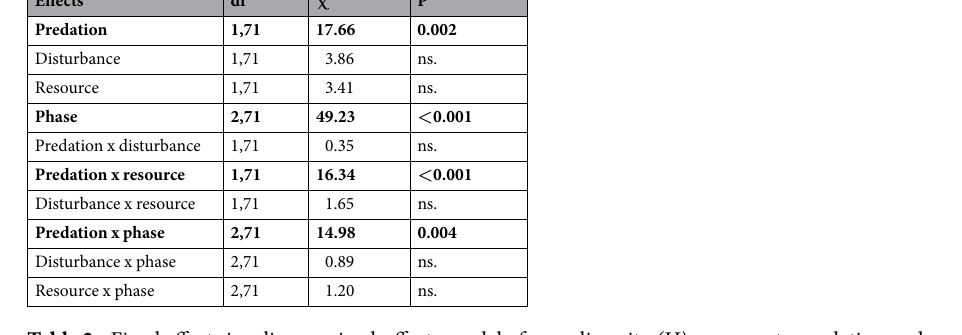
Table 2. Fixed effects in a linear mixed-effects model of prey diversity (H) response to predation and disturbance. Df is degrees of freedom, χ 2 and p values were derived from the parametric bootstrap. Significant effects are highlighted in